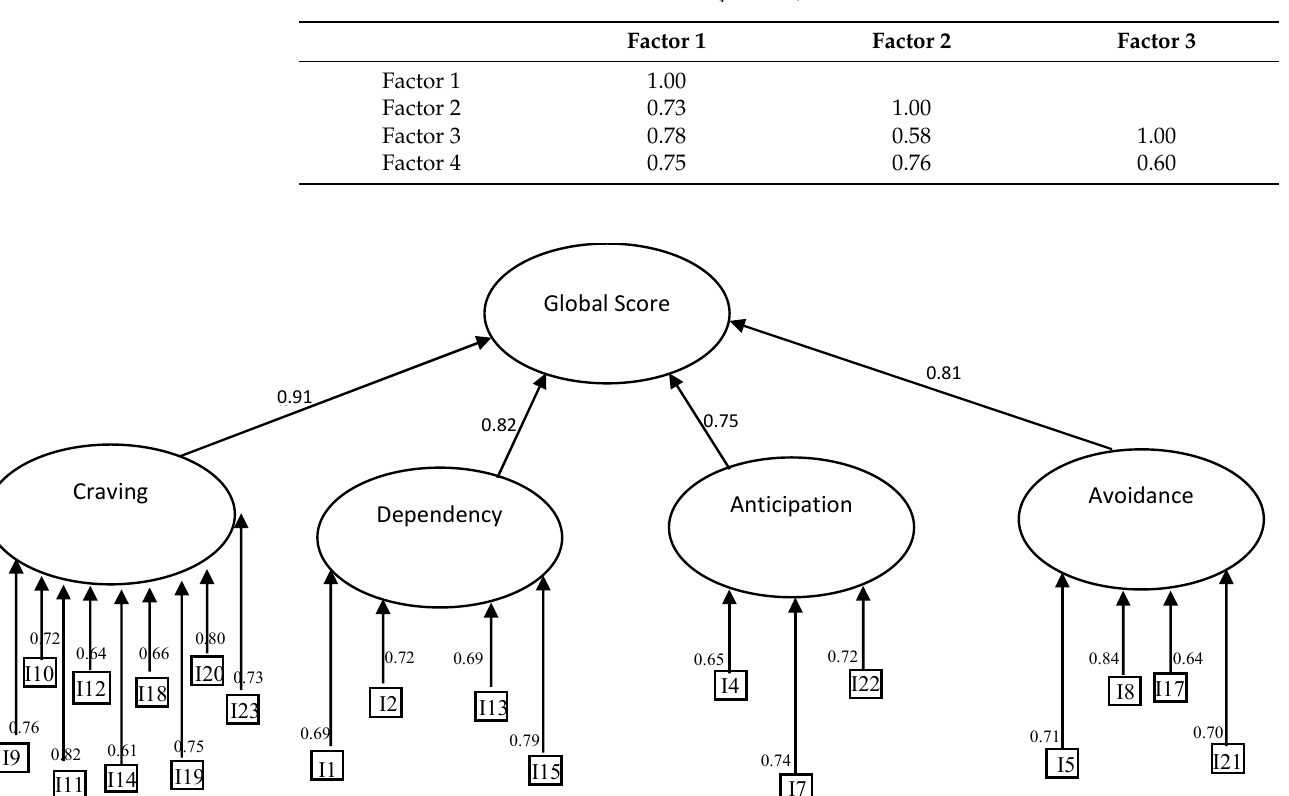
Table 5. BWAQ factors correlation matrix ( p < 0.01).